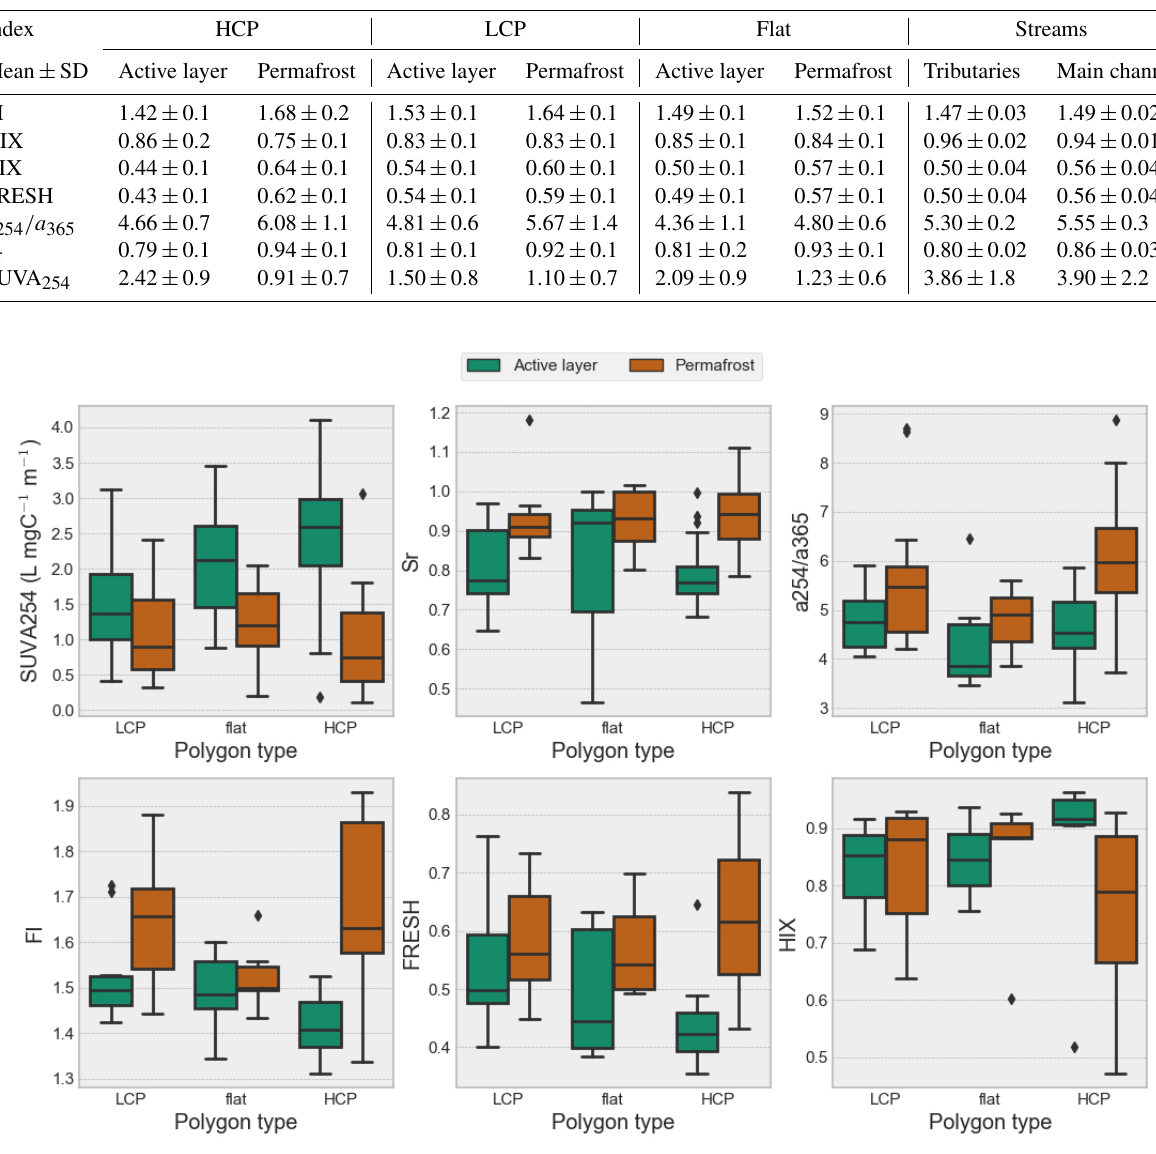
Table 5. Summary of fluorescence and absorbance indicators of DOM quality. Significant differences and sample sizes are indicated in Table S4.